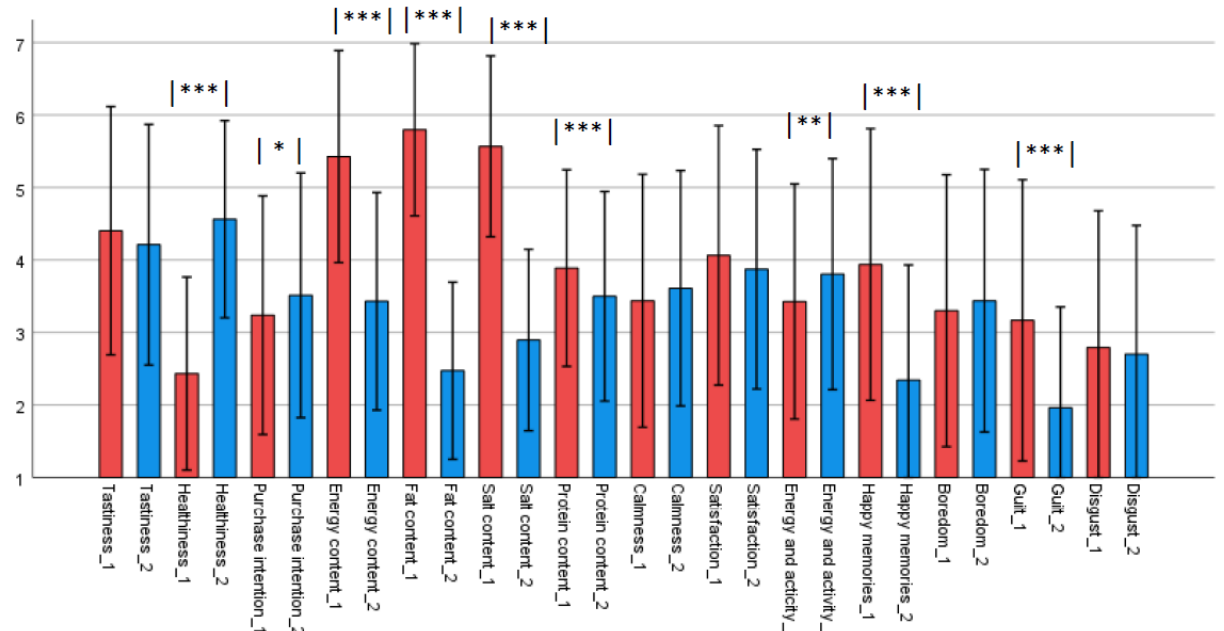
The sample products were selected to represent typically different images of health and nutrient content: the unhealthy product with fat and salt, and the healthy product with less fat and salt and rich in vegetables. The results confirmed the image difference between the sample products. The expected attribute profile of product 1 (unhealthy product; fried potatoes and sausages) was found to be less healthy ( p < 0.001), and the product had higher ratings for energy, and fat and salt content ( p < 0.001) compared to product 2 (healthy product; vegetable lentil soup). For the other expected attributes, the two products were rated quite similarly: there were no significant differences between the expected tastiness of the products or the expected emotions: calmness, satisfaction, boredom, and disgust. The only differences between the expected emotions associated with the products were guilt and